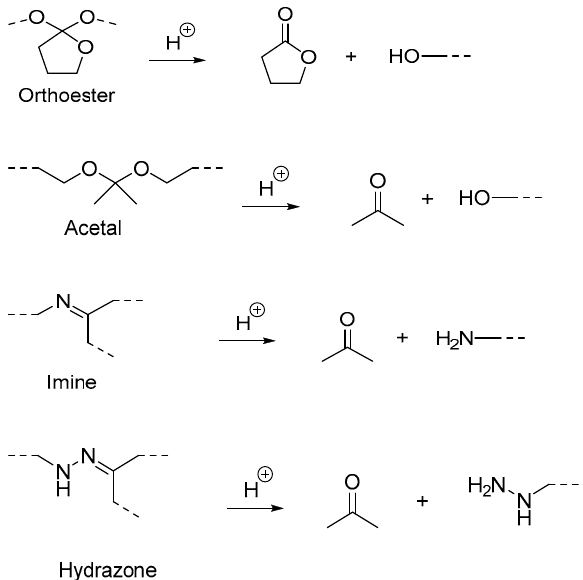
Figure 5. Examples of cleavage of acid-labile linkages and their degradation product.